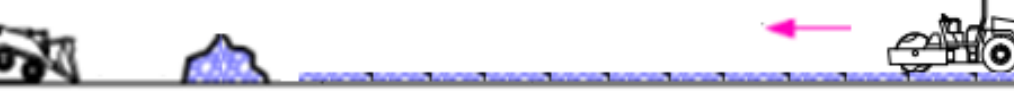
Figure 14. Filtered Tailings Compaction Field Trial—Construction Method.